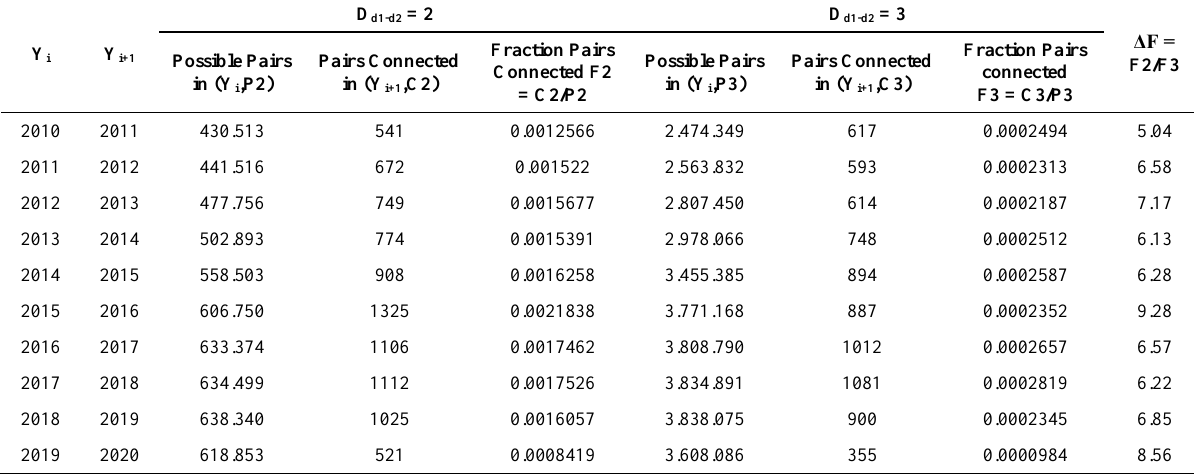
Table 1. Cyclic Closure Bias Evaluation in UK